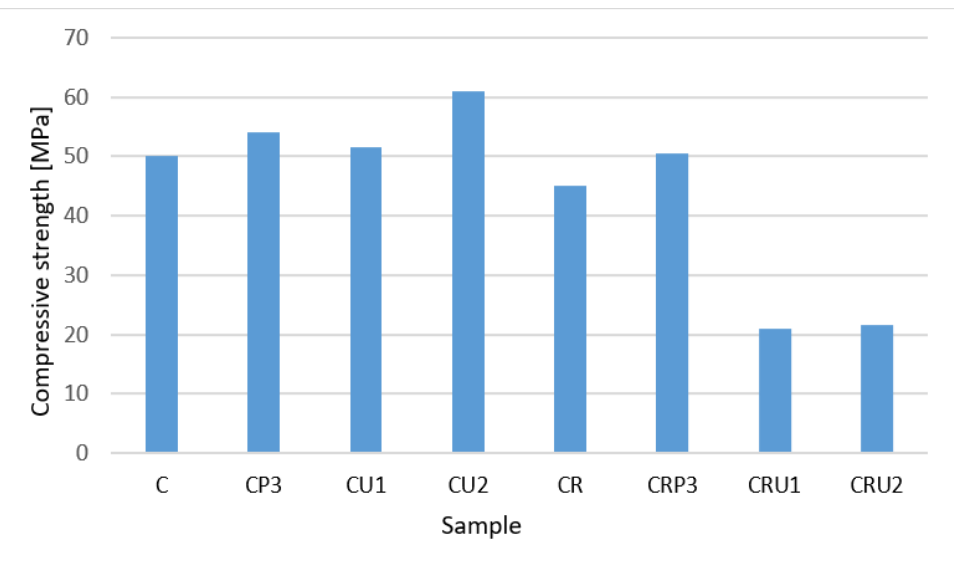
Figure 4. Compressive